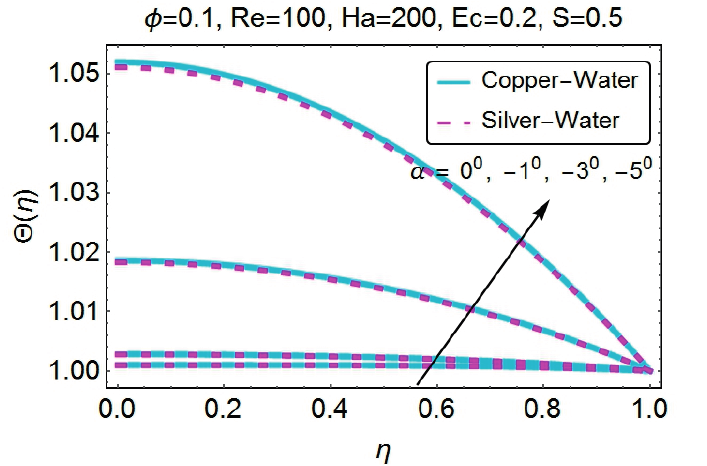
Figure 13. Change in temperature for varying α (divergent channel/shrining case).